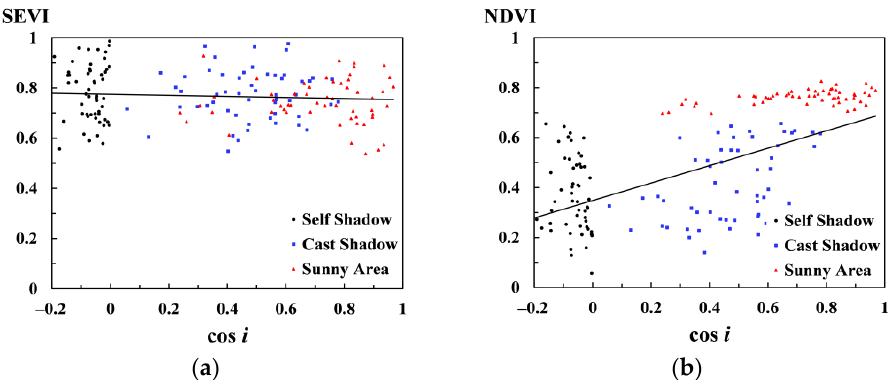
Figure 7. Scatter plots of vegetation indices vs. the cosine of the solar incidence angle (cos i ): ( a ) SEVI; ( b ) NDVI. ( b )